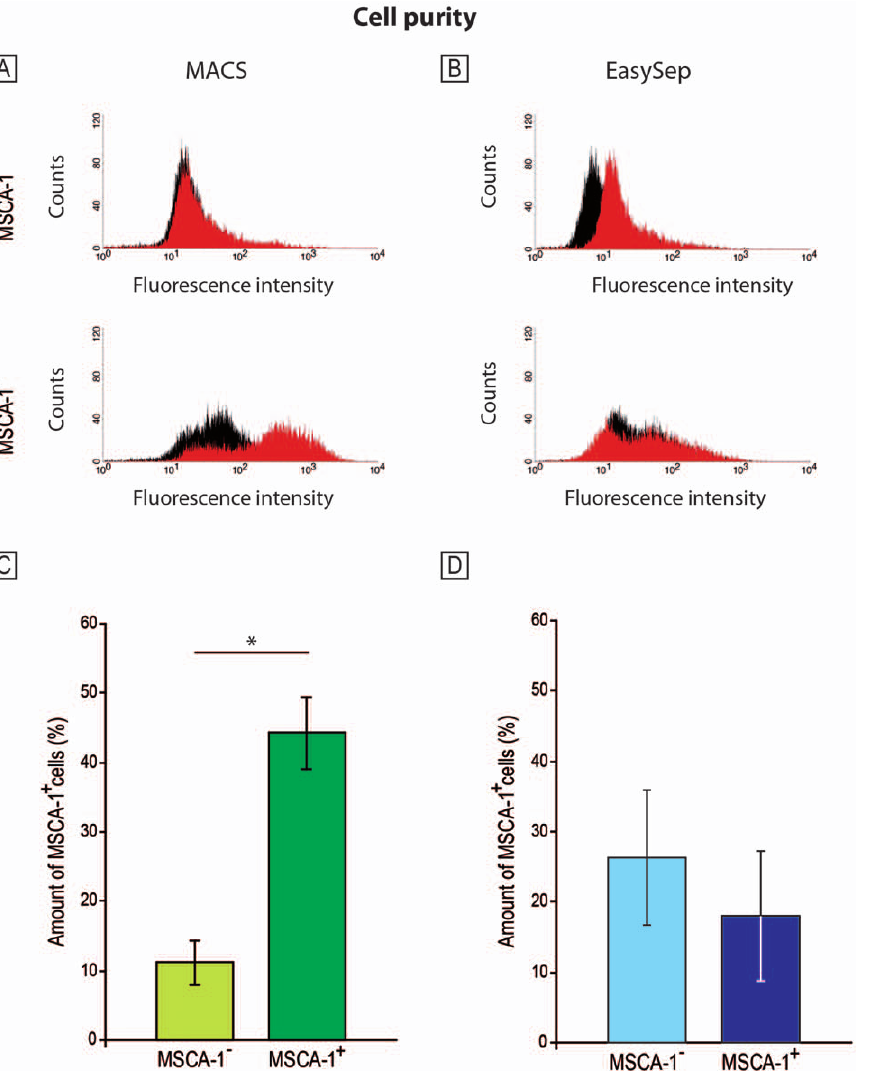
Figure 2. Cell purity of MACS (A, C) and EasySep (B, D) separated cell fractions as determined by flow cytometric analysis. After the magnetic separations, the cells were labeled with the anti-MSCA-1 supernatants and the PE-labeled secondary antibodies and MSCA-1 expression was analyzed by FACS. In the upper panel of the figure, representative flow cytometric histograms of MSCA-1 2 / + are illustrated. Fig. 2C and 2D show the results of the quantification of the MSCA-1 + cells within the MACS/EasySep separated fractions (n=4). MSCA-1 expression was significantly different (p , 0,021) between the MACS- but not EasySep-separated MSCA-1 2 (11.15 6 3.17) and MSCA-1 + (44.26 6 5.24) cell fractions.